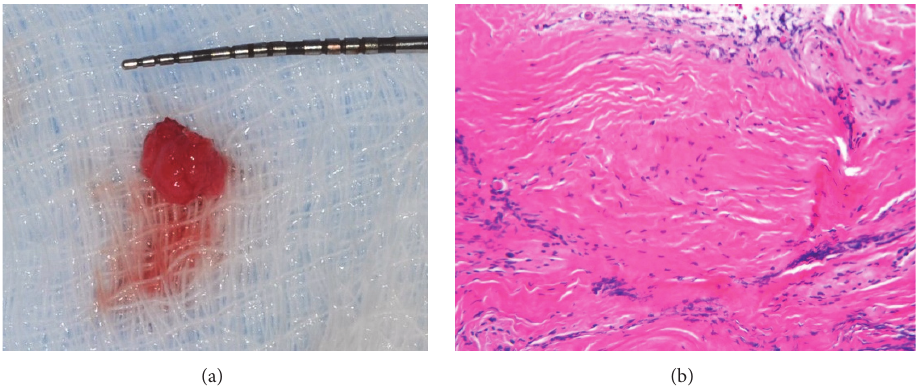
Figure 4: The removed specimen and histopathological picture (H&E stain). Approximate 5 × 5 × 3mm elastic hard granulation tissue was removed from the erratic extraction site (a). Fibrous connective tissue with inflammatory cells infiltration (b).